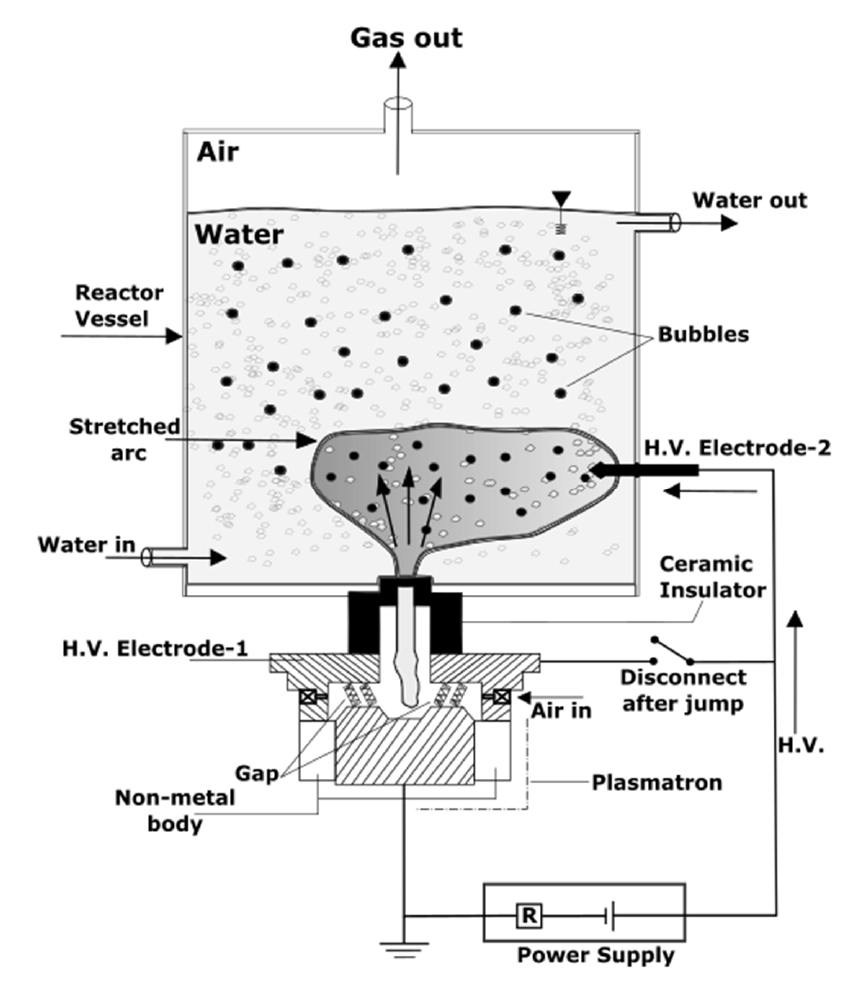
Figure 7. The scheme of a stretch arc plasma applied for produced water treatment .